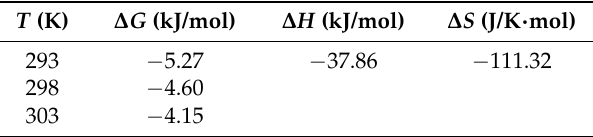
Table 4. Calculated thermodynamic parameters.